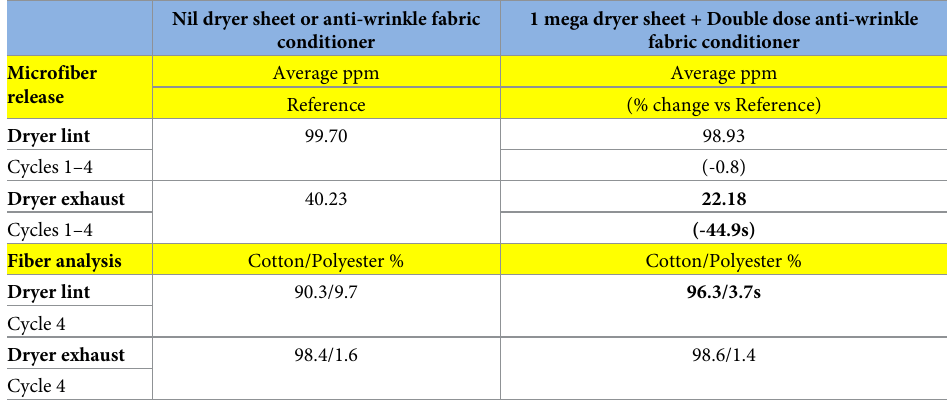
Table 5. Summary of microfiber release and fiber analysis data–North America combination of tumble dryer sheet with liquid anti-wrinkle fabric conditioner.